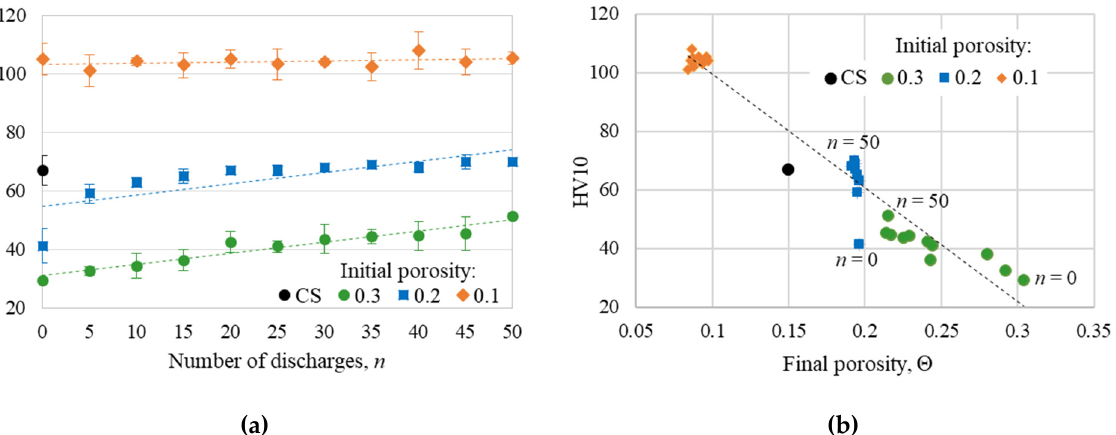
Figure 7. Microhardness (HV10) of the CEDC specimens with initial porosities of 0.3, 0.2, and 0.1 as a function of ( a ) the number of discharges and ( b ) the final porosity. Microhardness of the conventionally sintered (CS) specimen is given for comparison.